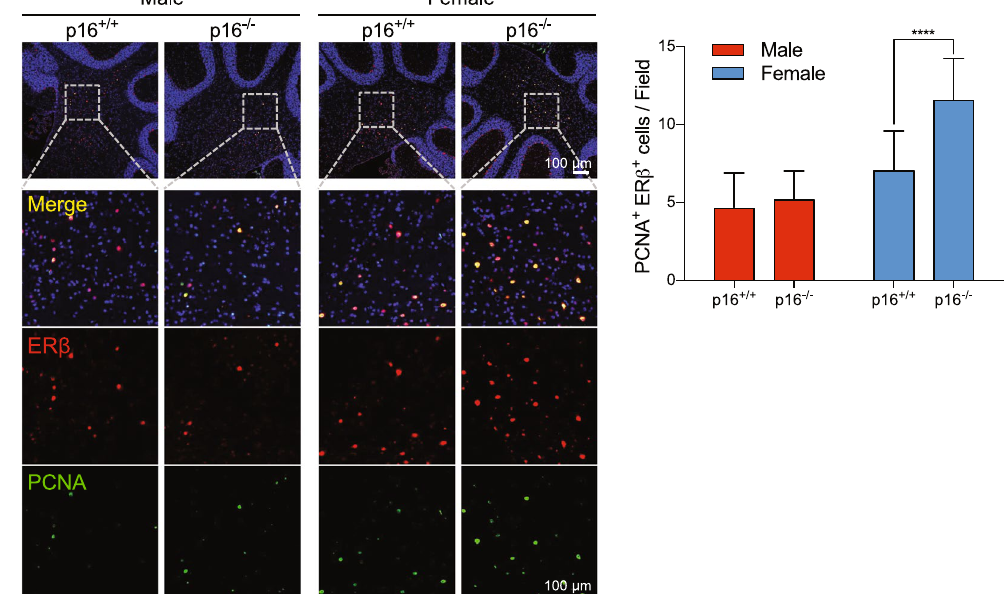
Figure 5. Estrogen signaling promotes the proliferation of neural cells in deep cerebellar nuclei region of female p16 Ink4a knockout mice. Sections of deep cerebellar nuclei from p16 + / + and p16 − / − FVB male and female mice were stained with anti-ER β (red) and anti-PCNA (green) to quantify ER β + PCNA + cells/field. Nuclei were stained with DAPI (blue) (n = 15–21). Results are mean ±